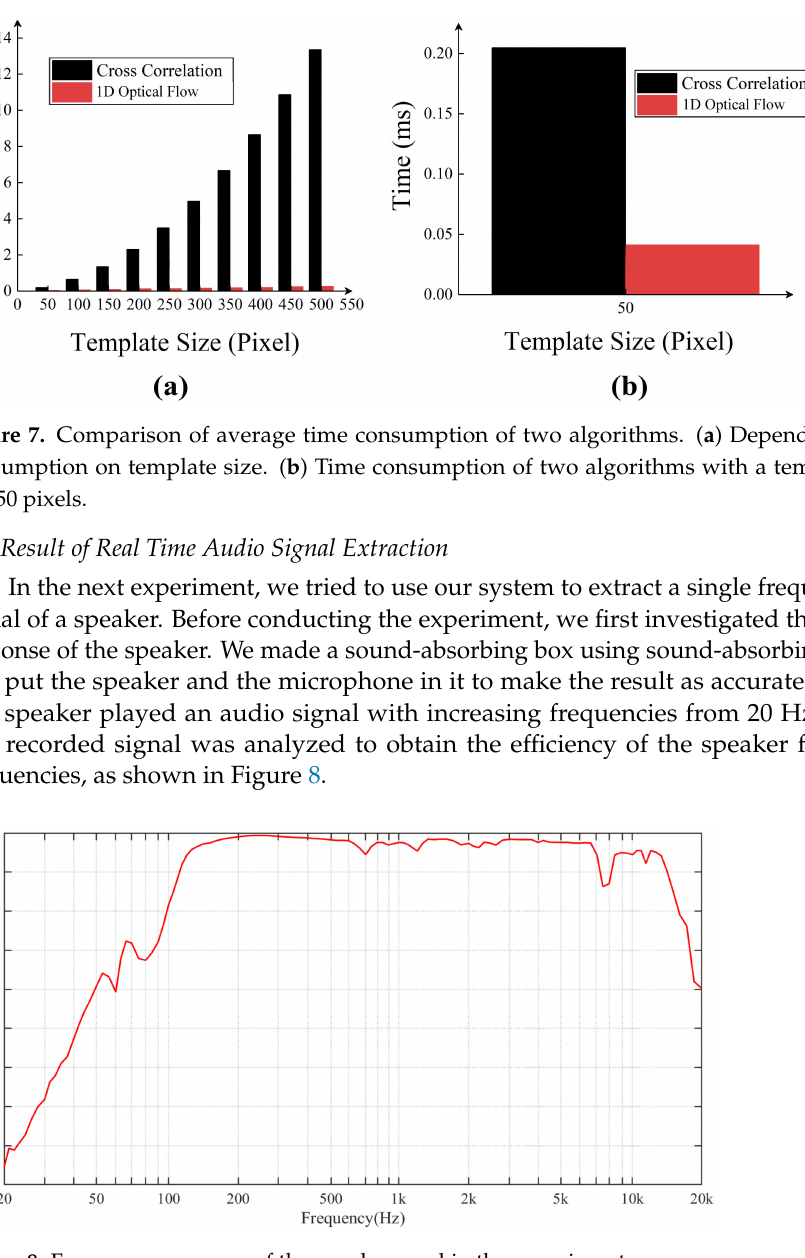
Figure 8. Frequency response of the speaker used in the